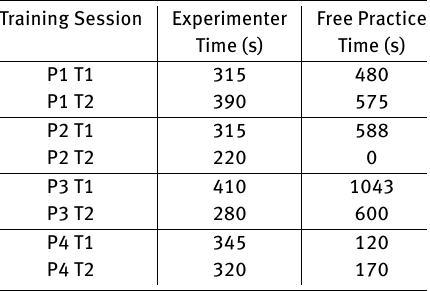
Table 4. Time spent on training (seconds). Experimenter time is the time spent proctoring the script before free practice began.